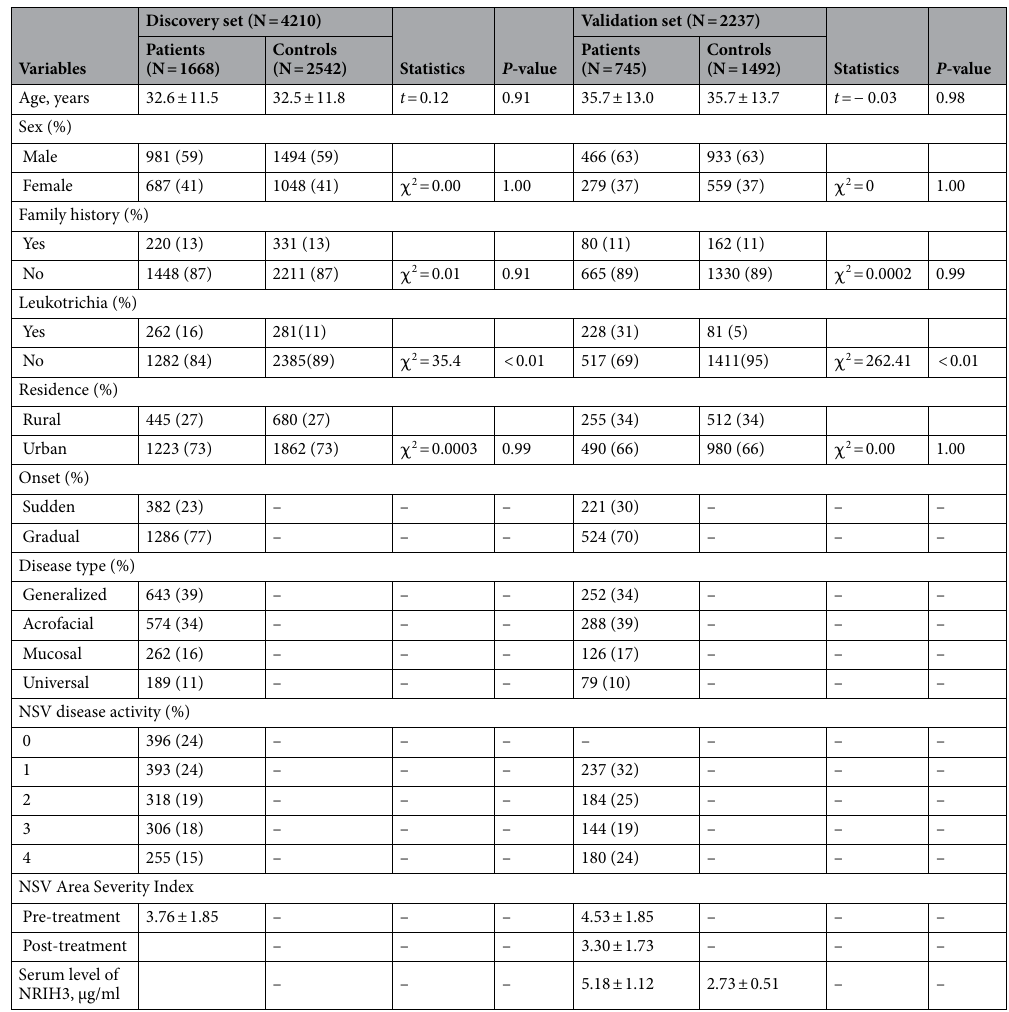
Table 1. Demographic and characteristics of the study subjects. Continuous variables were presented by mean ± standard